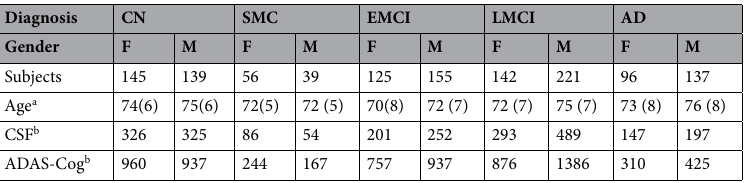
Table 1. Counts of subjects and observations by baseline diagnosis and gender. a Age in years, mean (std), b number of